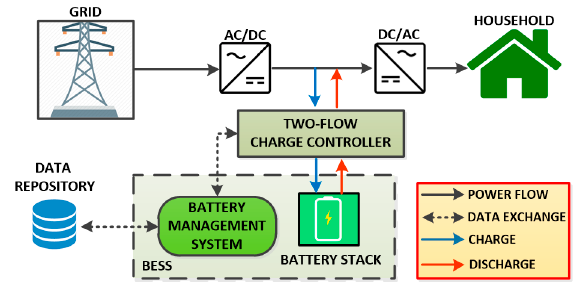
Figure 2. Residential BESS without RES.